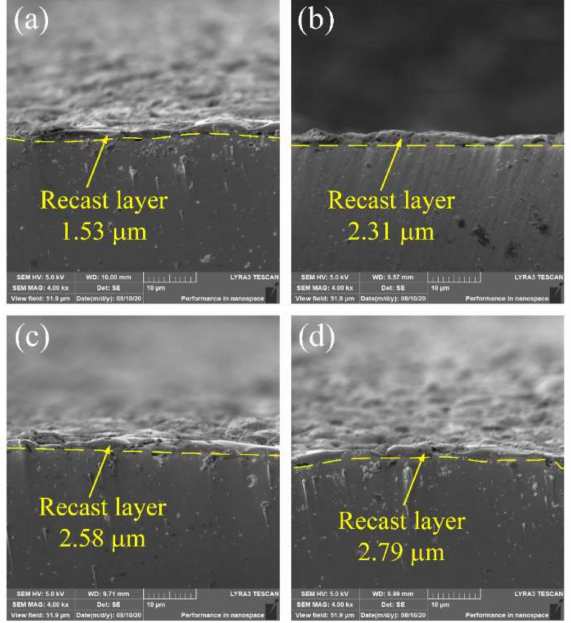
Figure 11. Cross-section images of EDM-treated TiNi SMA under pulse widths of ( a ) 1 µ s, ( b ) 4 µ s, ( c ) 7 µ s, and ( d ) 10 µ